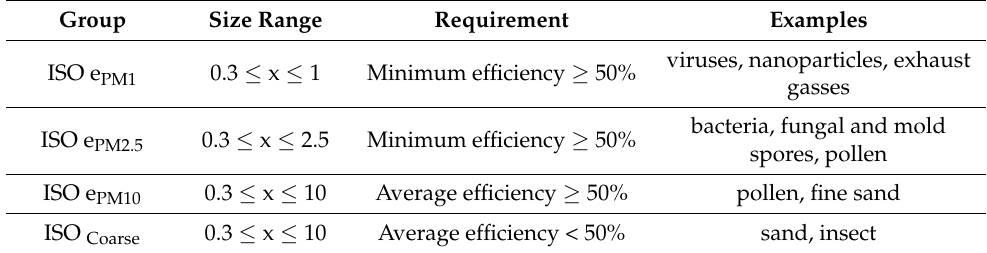
Table 6. Classification according to ISO 16890